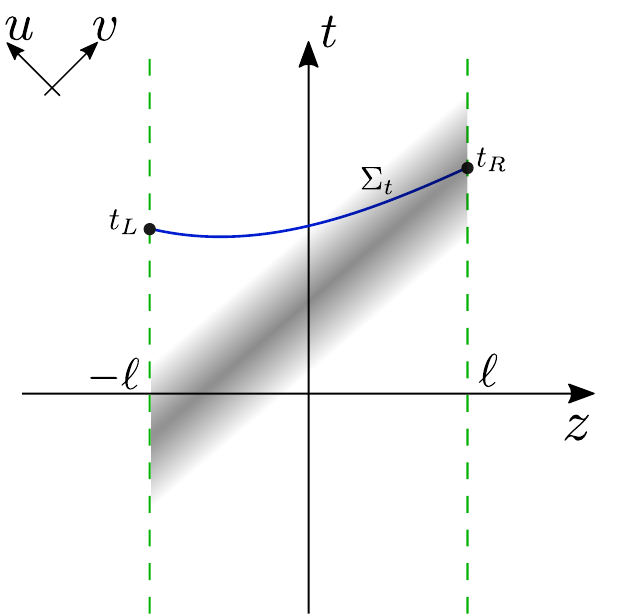
Figure 3 . Schematic representation of the extremal surface for a pp-wave pulse traversing the box of size 2 ‘ from left to right. The transverse R 2 plane is not